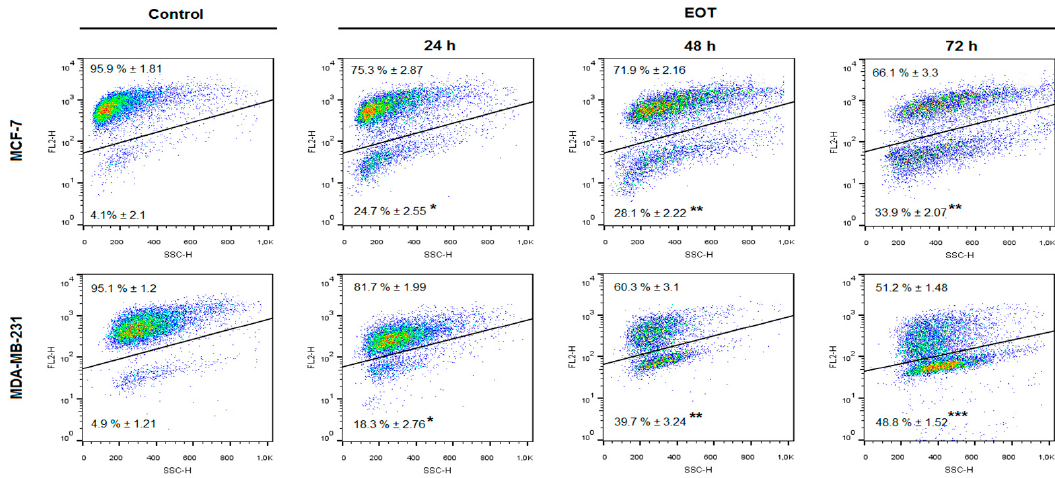
Figure 10. The effects of EOT treatment (0.13 or 0.12 µg/mL) on changes of mitochondrial membrane potential (MMP) in MCF-7 and MDA-MB-231 cells. Data were obtained from three independent experiments and significant differences are shown: * p < 0.05, ** p < 0.01, *** p < 0.001 versus control cells (untreated).